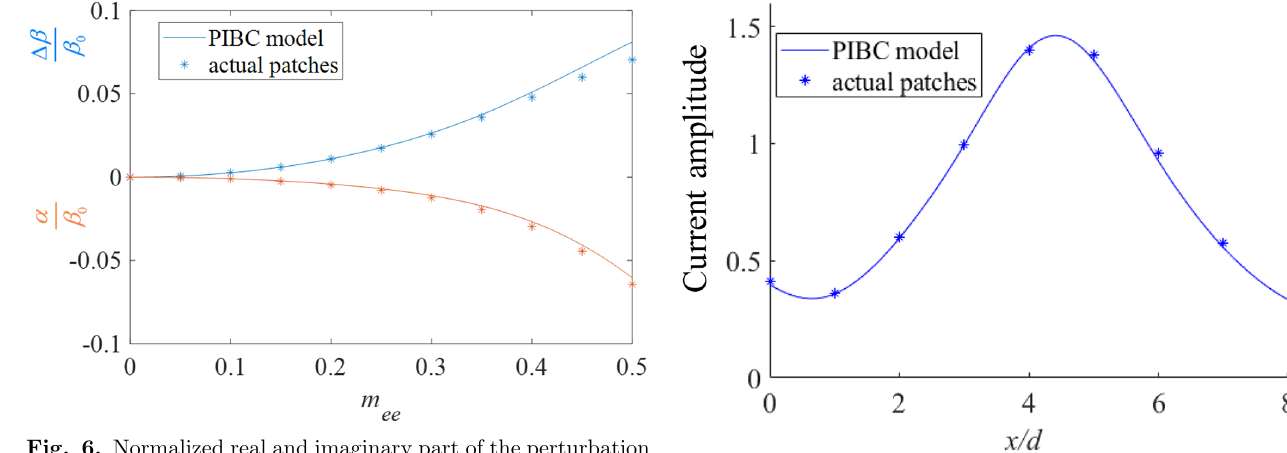
Fig. 6. Normalized real and imaginary part of the perturbation of the propagation constant on a modulated MTS. Comparison between penetrable impedance model and rigorous full wave analysis for different values of the modulation index.